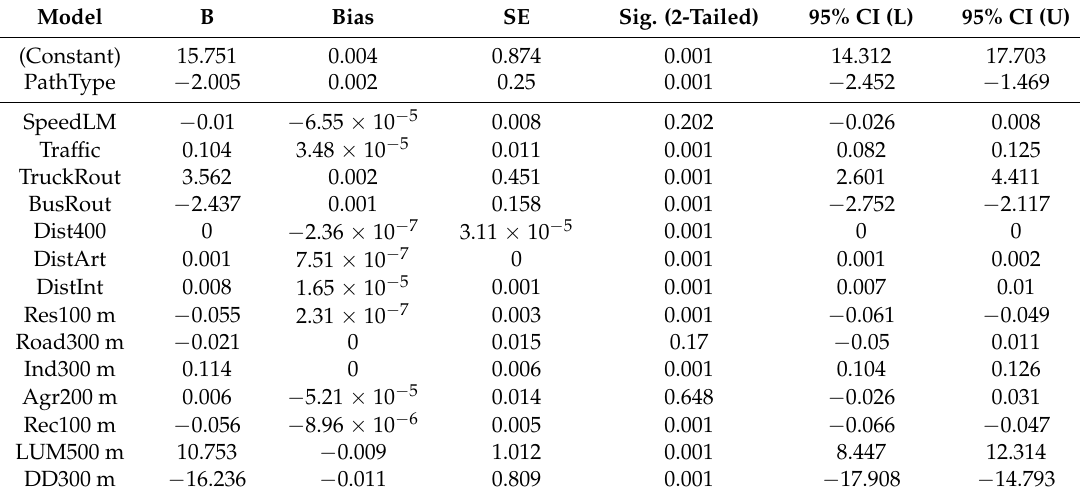
Table A1. Day2. Bootstrap for Coefficients.